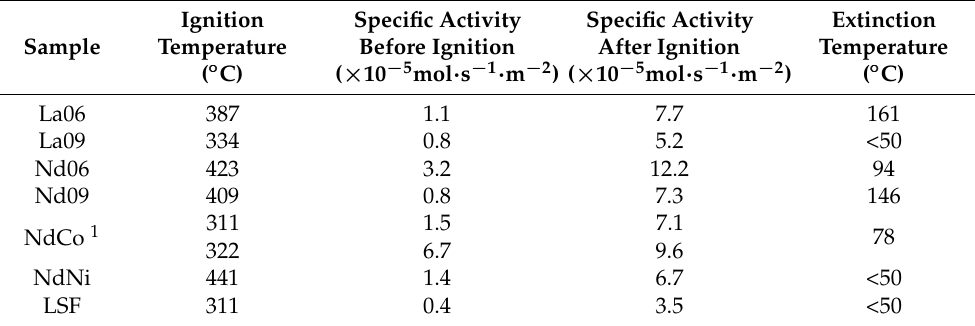
Table 2. Ignition and extinction temperatures of all samples and LSF. The specific activities before extinction and after ignition are also